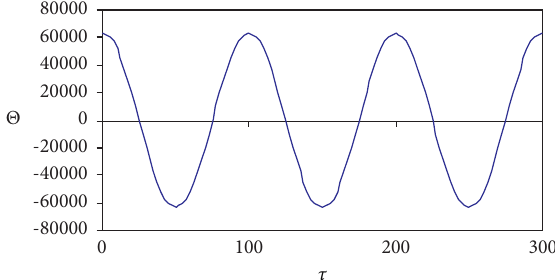
Figure 27: The analytical solution Θ for case (iii) in Section 4.2.